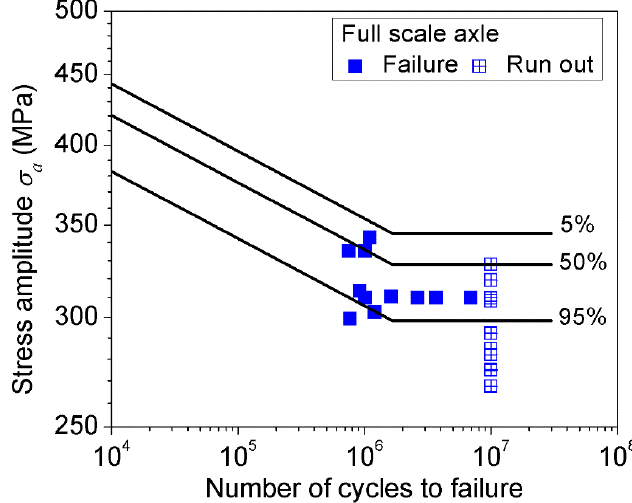
Figure 11. Comparison of predicted P-S-N curves with experimental data of full scale EA4T axles [24] by using the fatigue strength data from the small specimen [24].